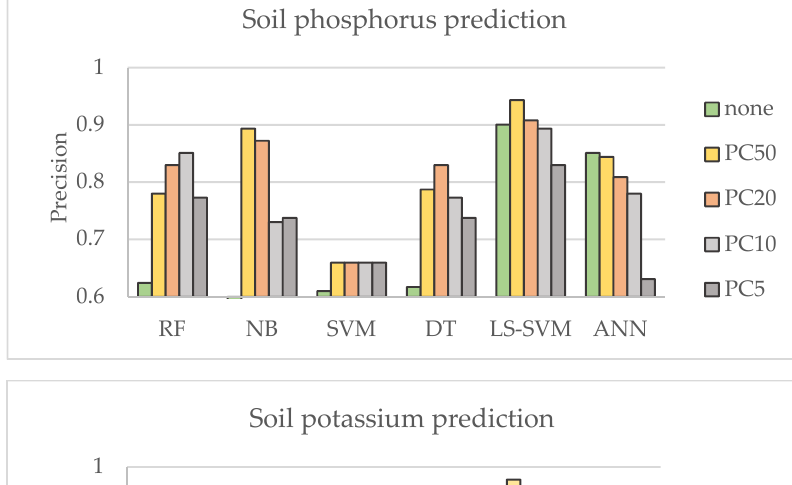
Figure 4. Comparison of the results corresponding to different machine learning techniques for Lo- cal soil dataset using Category II system for category labelling.